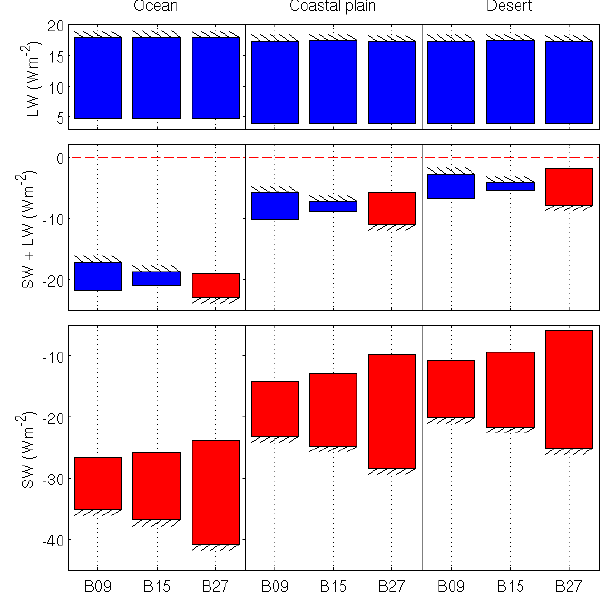
Figure 16. Daily mean dust DRF for B09, B15 and B27 RI (indi- cated by the vertical dash line in each column) and ocean, coastal plain and desert (left to right) surface albedo over the Arabian Peninsula. Each bar represents three diagnostic variables: (cid:49)F TOA , (cid:49)F BOA and (cid:49)F A . Hatching indicates the (cid:49)F BOA edge and thus the opposite edge is (cid:49)F TOA . The height of the bar corresponds to the absolute value of the atmospheric absorption due to dust or (cid:12) (cid:12) (cid:12) (cid:12) (cid:49)F A (cid:49)F A (blue for negative (cid:12) (cid:12) and color indicates the sign of the or cooling, red for positive or warming). LW, SW values and their sum are shown in the top, bottom and middle rows,